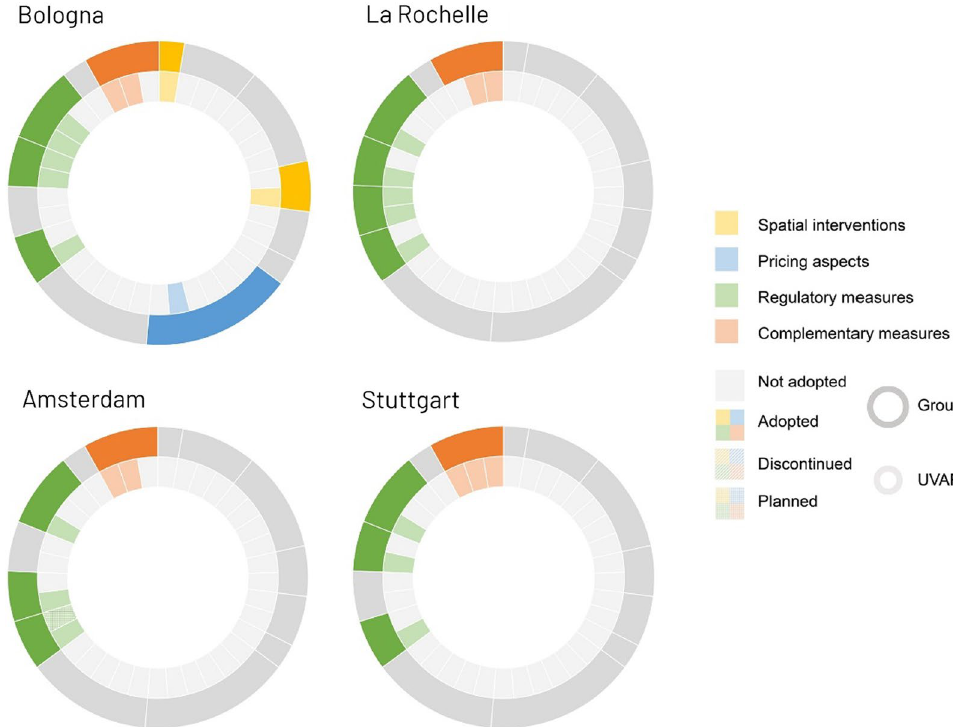
Fig. 13 UVAR measures implemented in the primarily regulatory-based strategies